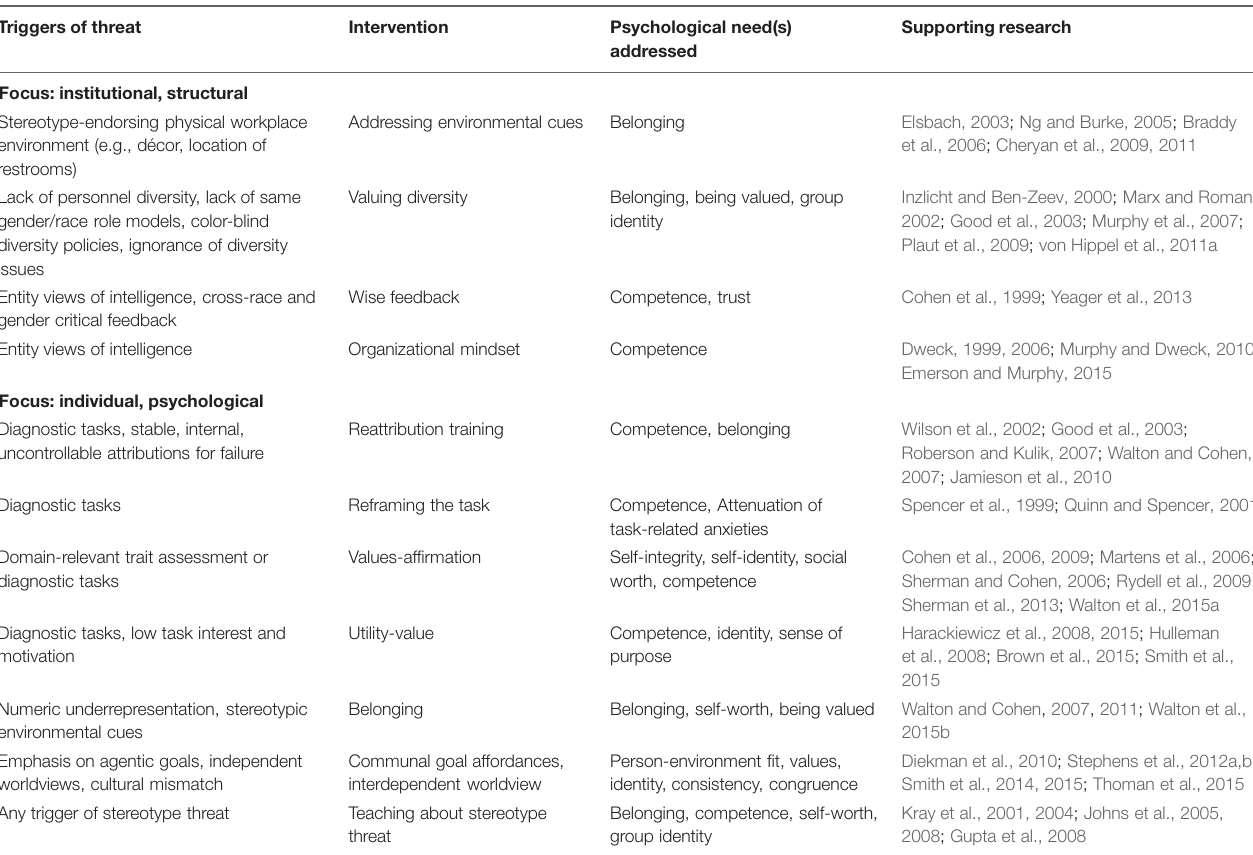
TABLE 1 | Summary of stereotype threat interventions adaptable to the